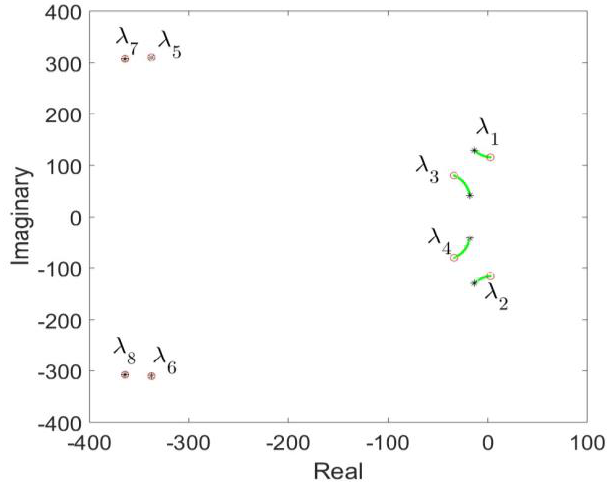
Figure 12. Eigenvalue loci of closed loop system with k ipll from 1 to 3.